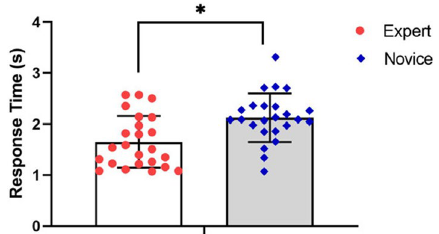
Figure 2. Comparison of the response time between groups.